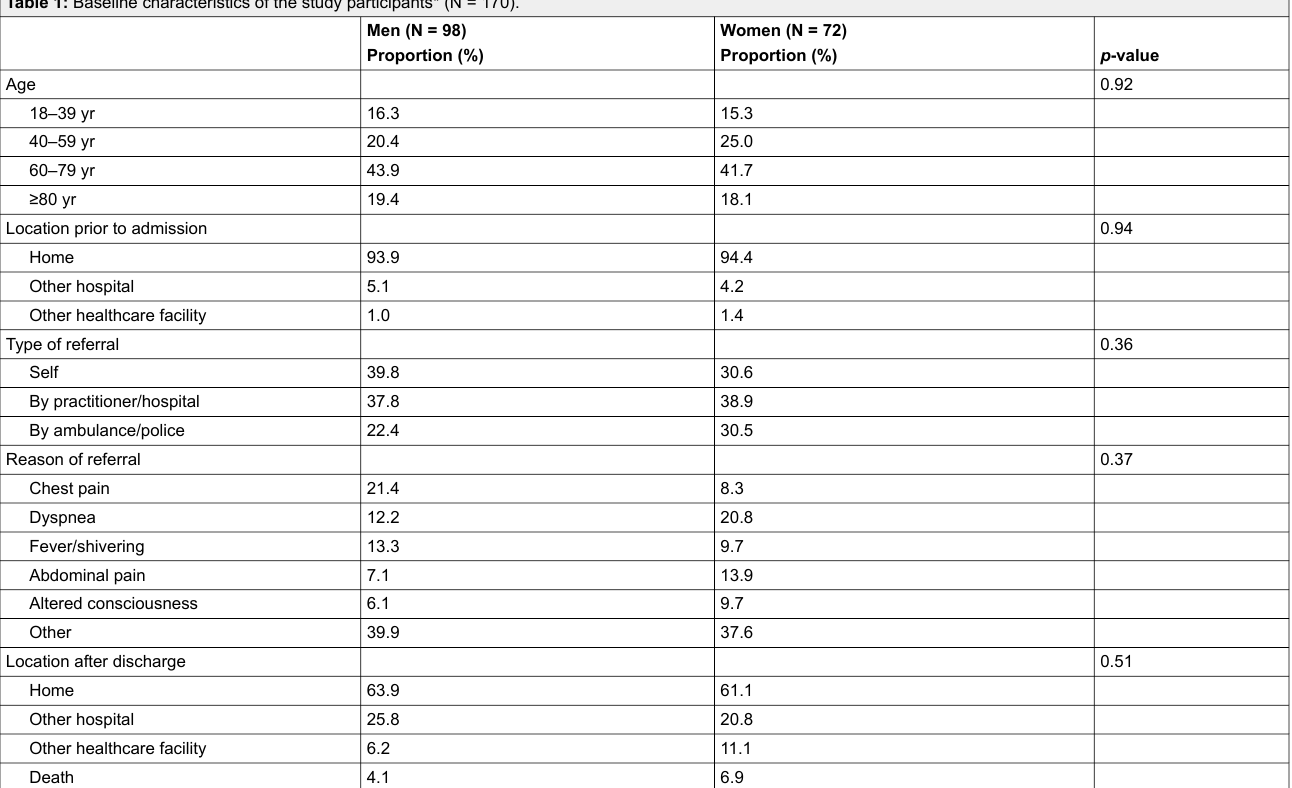
Table 1: Baseline characteristics of the study participants* (N =